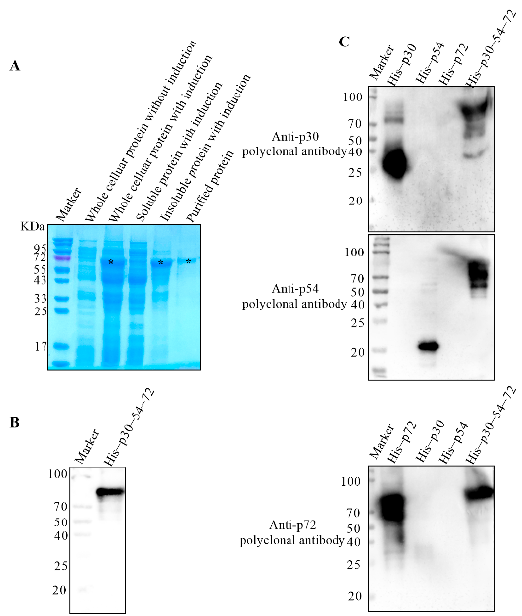
Figure 6. Identification of His–p30–p54–p72 protein. The cellular or purified proteins were electrophoresed on 10% SDS–PAGE and visualized by coomassie brilliant blue G250 staining ( A ) or were transferred to PVDF membrane probed with anti–His monoclonal antibody ( B ). ( C ) Identification of the His–p30–p54–p72 protein by rabbit anti–p30, –p54 and –p72 polyclonal antibody. *: the target